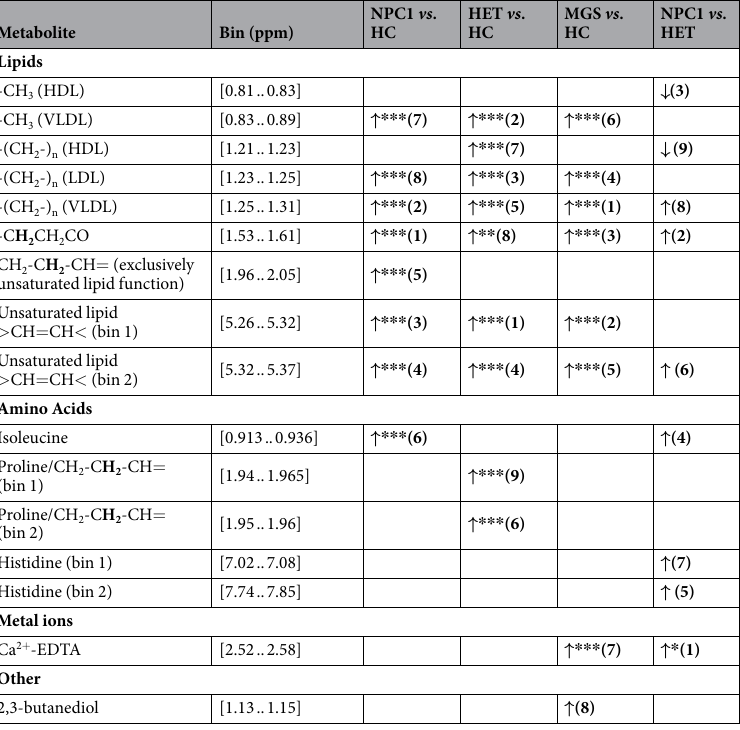
Table 3. Significant random forest discriminatory variables. Arrows indicate an increase/decrease in the measured metabolite with respect to the HC samples or with respect to the HET samples in the case of the NPC1 v. HET comparison. The results of the Tukey’s HSD test for each metabolite identified by the random forests analysis are indicated by an asterisks (Bonferroni corrected p -values < 0.05, 0.01, 0.001 are represented by * , ** , and *** respectively). The order in which the discriminatory variables were ranked by random forest analysis based on their MDA value is represented in brackets (1 = discriminatory variable with highest MDA).